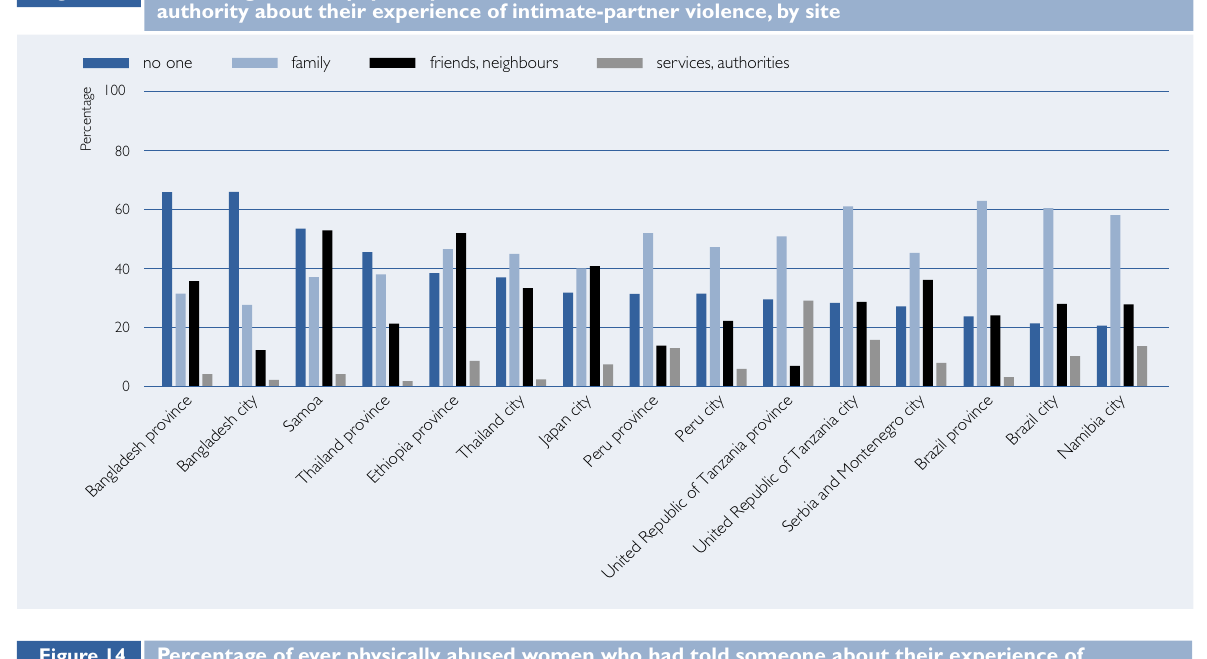
Figure 14 Percentage of ever physically abused women who had told someone about their experience of intimate-partner violence, compared with the percentage of ever physically abused women who had sought help, by